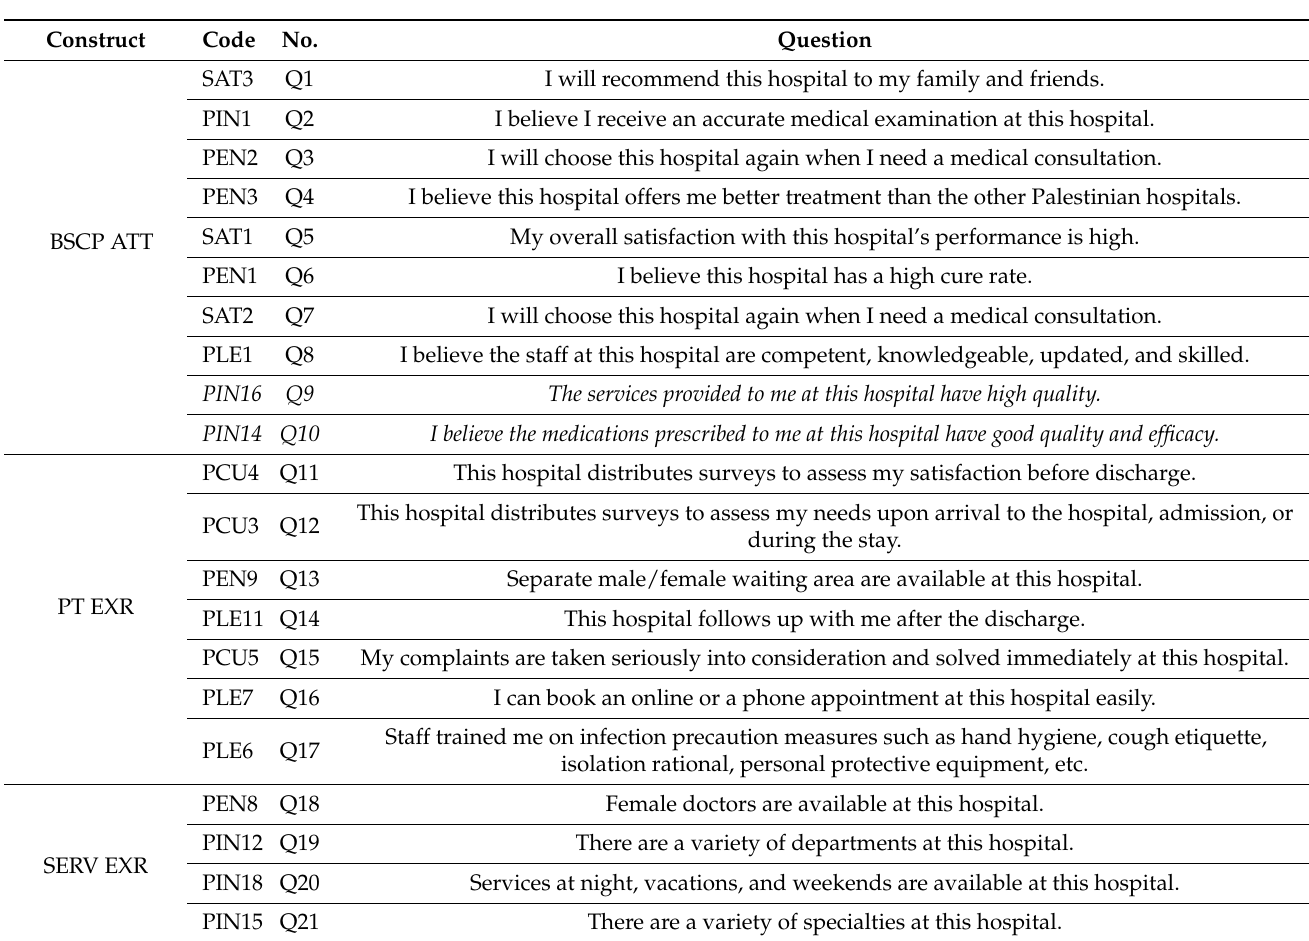
Table A2. Items tested in